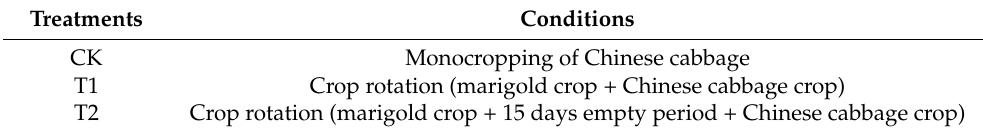
Table 5. Experimental